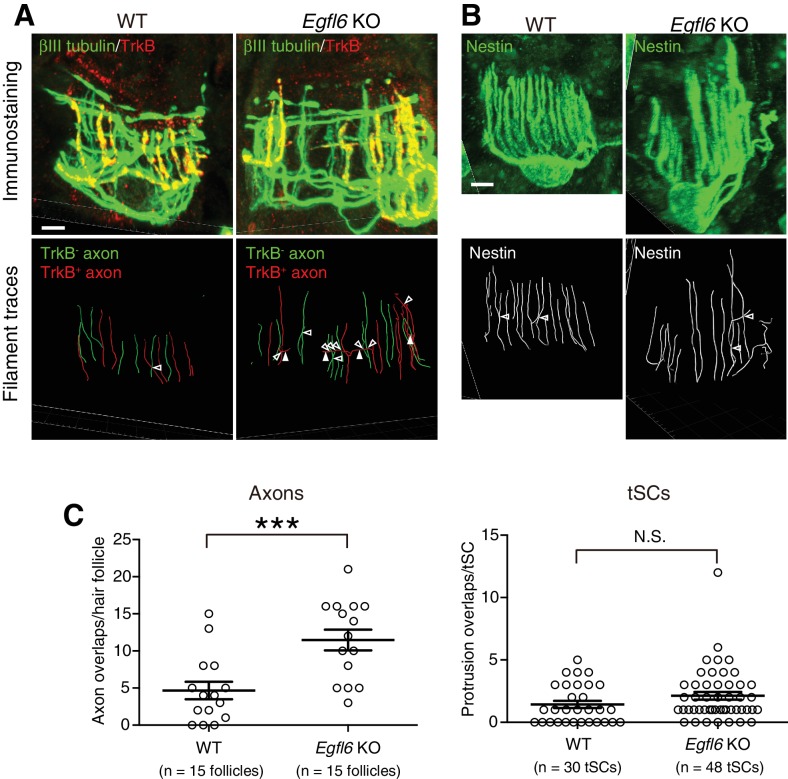
EGFL6 is required for the patterning of lanceolate complexes at the first telogen.(A–B) 3D reconstituted images and filament tracings of axonal endings (A) and terminal Schwann cells (B) of zigzag hair follicles in wild-type and Egfl6 knockout mice at P19 first telogen. βIII-tubulin staining visualizes all LTMR axonal endings, including circumferential nerve endings. TrkB is a marker for Aδ-LTMRs. In zigzag hair follicles, TrkB- LTMRs are C-LTMRs. In the mutant, overlapping points of axonal endings (open arrowheads) were increased. This was partly due to the increase of horizontally extending branches of TrkB+ axonal endings (closed arrowheads) in Egfl6 knockout. These horizontally extending branches were also observed in wild-type lanceolate complexes with low frequency in the first telogen. Disorganized shape of terminal Schwann cells was occasionally observed in the mutant, but there is no significant difference in the number of terminal Schwann cell protrusion overlaps (see quantification below). Scale bars, 5 μm. (C) Overlapping points of axonal endings and terminal Schwann cell processes were counted. Data are mean ± SEM. Two-tailed unpaired t-test. Fifteen hair follicles from three wild-type mice and 15 hair follicles from three Egfl6 knockout mice were used for axon quantification. Thirty terminal Schwann cells from three wild-type mice and 48 terminal Schwann cells from three Egfl6 knockout mice were used for terminal Schwann cell quantification.